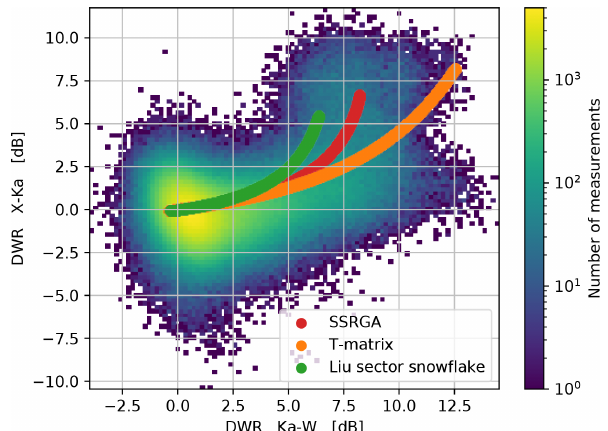
Figure 9. 2D histogram of DWR X–Ka and Ka–W measured dur- ing the TRIPEx campaign (Dias Neto et al., 2019) at the JOYCE supersite on 24 November 2015. The three colored curves show the simulated DWR–DWR relations based on the ICON–P3 model out- put and the three scattering methods used (SSRGA, T-matrix, and DDA